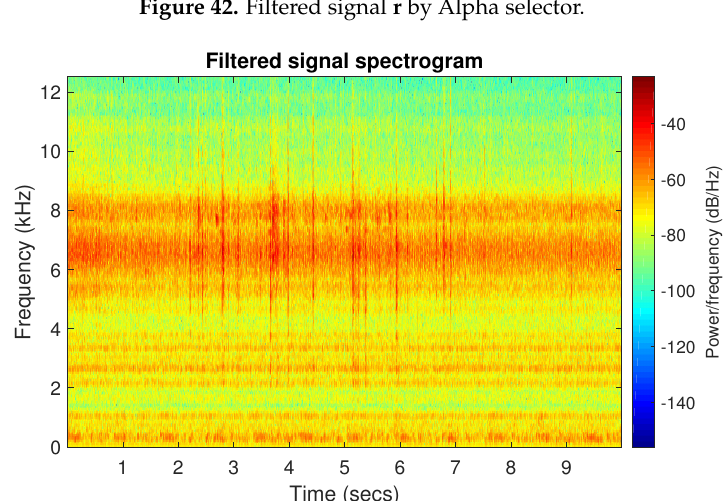
Figure 43. Spectrogram of filtered signal r by Alpha